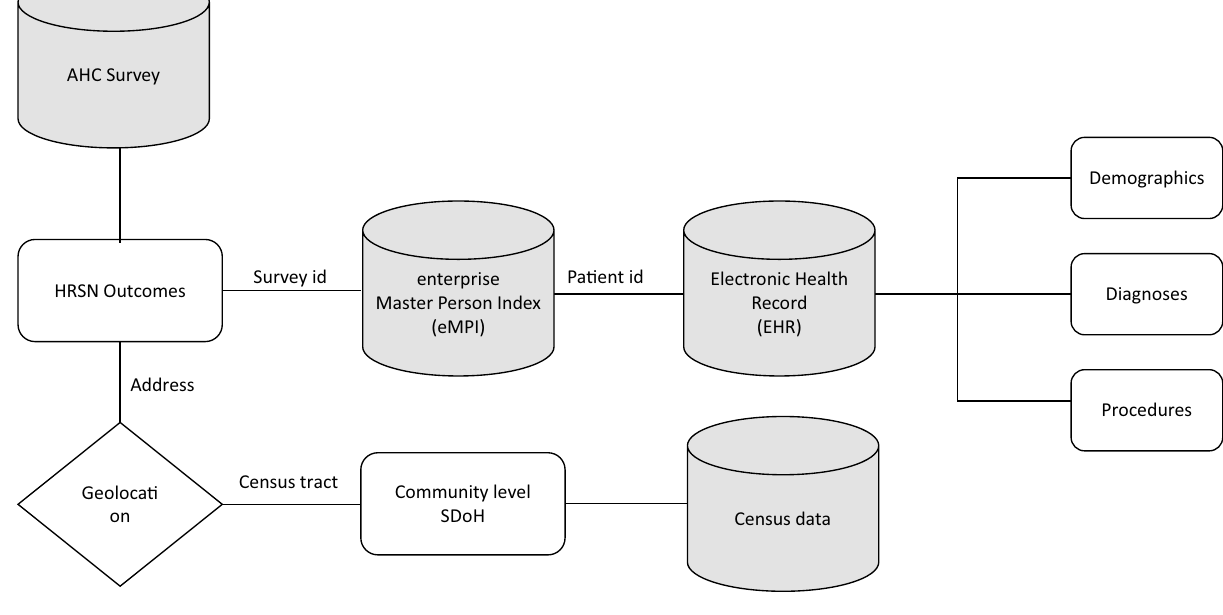
Figure 1. Data sources and linkage for modeling. Flow chart showing the data sources combined to create the dataset displayed. The data sources are displayed as three cylinders displaying the data linking between sources. The measures from each source are displayed as a rectangle linking to other cylinders. Patient-level HRSNs were collected in the AHC screening survey. Using survey demographic data, patients were mapped using a Master Patient Index database (MPI) to patient ID, demographics, diagnosis, and procedures in the EHR. Patients addresses provided in the survey and the EHR were geocoded to each patient’s address and corresponding Census tract. The geocoding is displayed as a diamond connected to the HRSN survey data